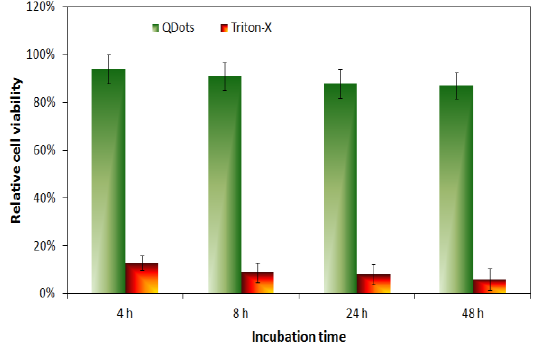
Figure 6. Relative cell viability of HUVEC cells exposed to Gel/CdS QDs at 5 µg/mL for 4, 8, 24 or 48 h as assessed through an Alamar blue assay.